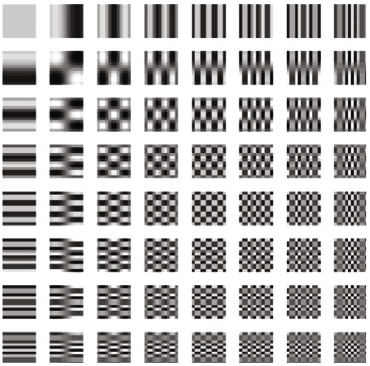
Figure 3: Basic waveforms of 8 × 8 DCT transformation.